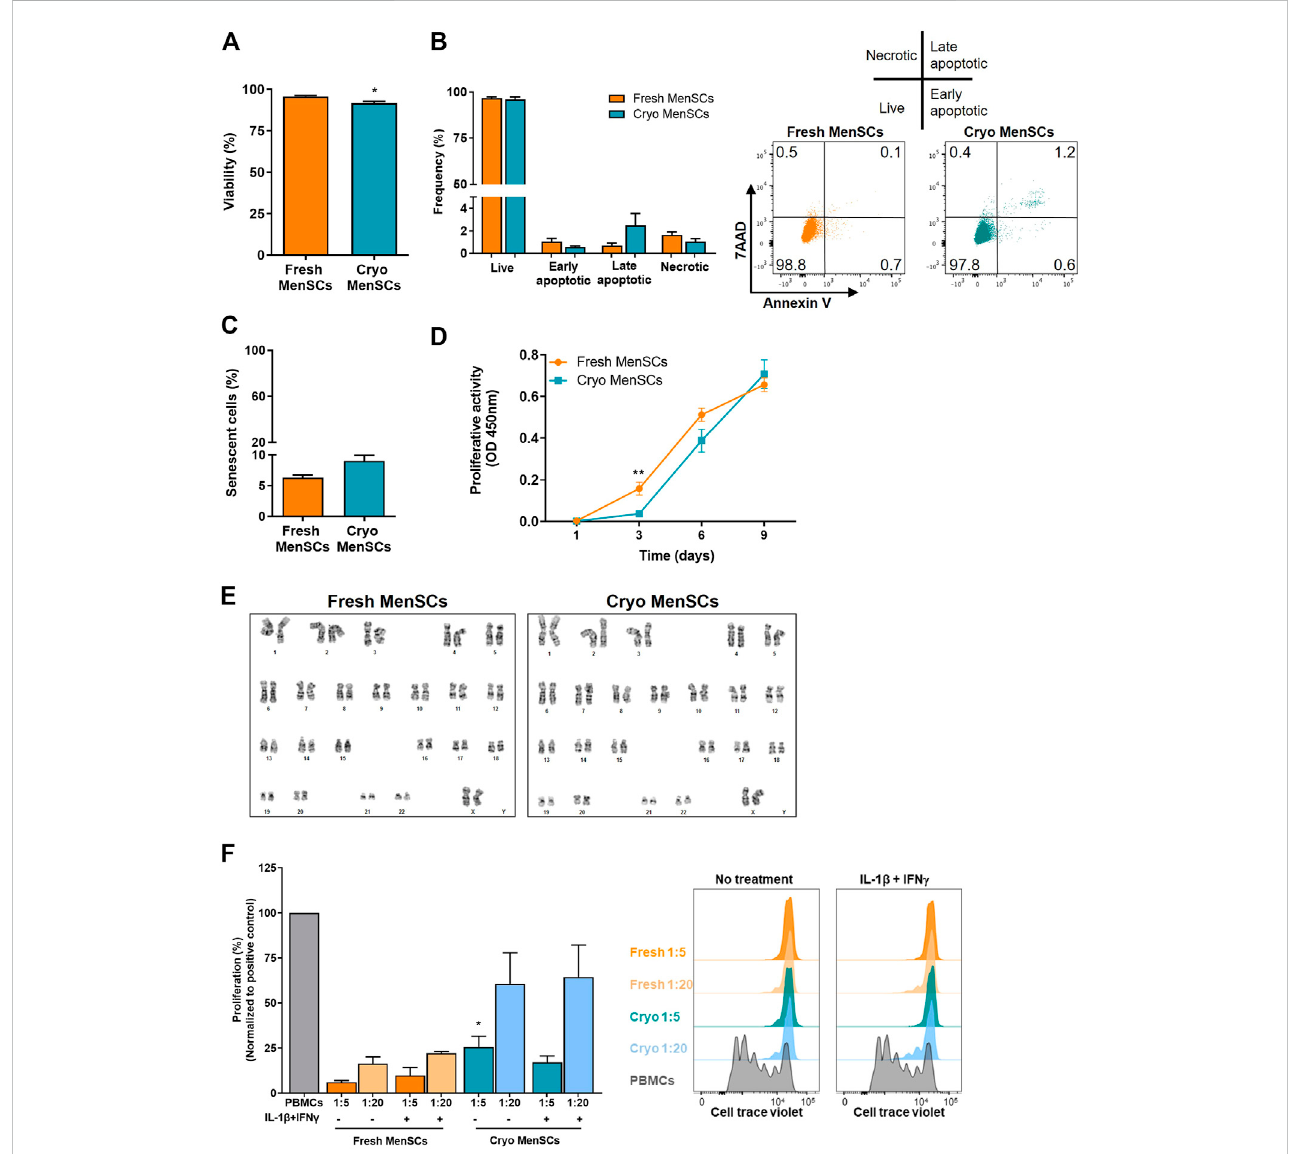
FIGURE 3 Viability, proliferative activity, senescence, karyotyping, and immunosuppressive properties of cryopreserved and fresh MenSCs. The analyses were performedwithcryopreservedandthawedcells(Cryo-MenSCs)comparedwithfreshculturecells(Fresh-MenSCs). (A) Cellviability wasdeterminedbytrypan blue dye exclusion assay. (B) Bar graph of apoptosis and necrosis, quanti fi ed by fl ow cytometry, after Annexin V and 7-aminoactinomycin D (7AAD) labelling. Representative dotplotsshowingintactcellsinthelower-left quadrant(Q4);earlyapoptoticcellsinthelower-rightquadrant (Q3);lateapoptoticcellsin the upper-right quadrant (Q2), and necrotic cells in the upper-left quadrant (Q1). (C) Senescence-associated β -galactosidase. MenSCs were cultured and harvested under standard conditions. Cells were viewed by phase contrast on a microscope and photographed with a digital camera. Positively stained cells for senescence-associated (SA)- β -galactosidase were counted, and the percentage of cells expressing SA- β -galactosidase in the total cell number of each sample was calculated. (D) Metabolic activity was measured at days 1, 3, 6, and 9 after seeding using WST-1 reagent (optical density [OD], 450 nm). (E) Karyotype of MenSCs by GTG banding. Representative images of cryo- and fresh cells. To study the immunosuppressive capacity of MenSCs on T cell response,an invitro TcellproliferationassaywasperformedatdifferentratiosofMSCs/Tcells,asdescribedintheMaterialandMethodssection.MenSCswere either unstimulated or were stimulated with interleukin (IL)-1 β +interferon- γ (IFN γ ) (10 ng/ml each) for 24 h before T cells co-culture in complete RPMI medium. Previously, human peripheral blood mononuclear cells (PBMCs) were labelled with Cell Trace Violet and stimulated with phytohaemagglutinin for 3 – 4days.Tcellproliferationwasevaluatedby fl owcytometry,gatingonCD45 + CD3 + cells. (F) Graphicalpresentationofthequanti fi eddataandrepresentative histograms of T cell proliferation in the presence and absence of MenSCs. Values are expressed as the mean ± standard error of the mean of three different MenSCs donors and at least three independent experiments. * p ≤ 0.05; ** p ≤ 0.01 (Cryo versus